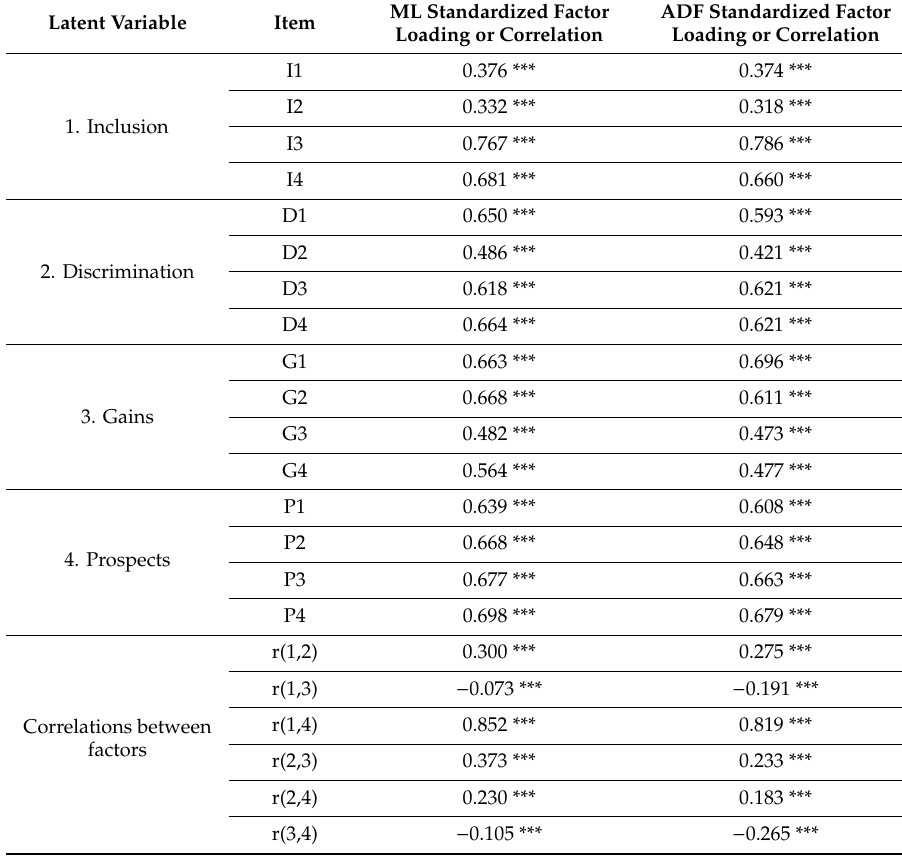
Table 5. Four-factor model: parameter estimates and significance (ML—maximum likelihood, ADF—asymptotically distribution free).